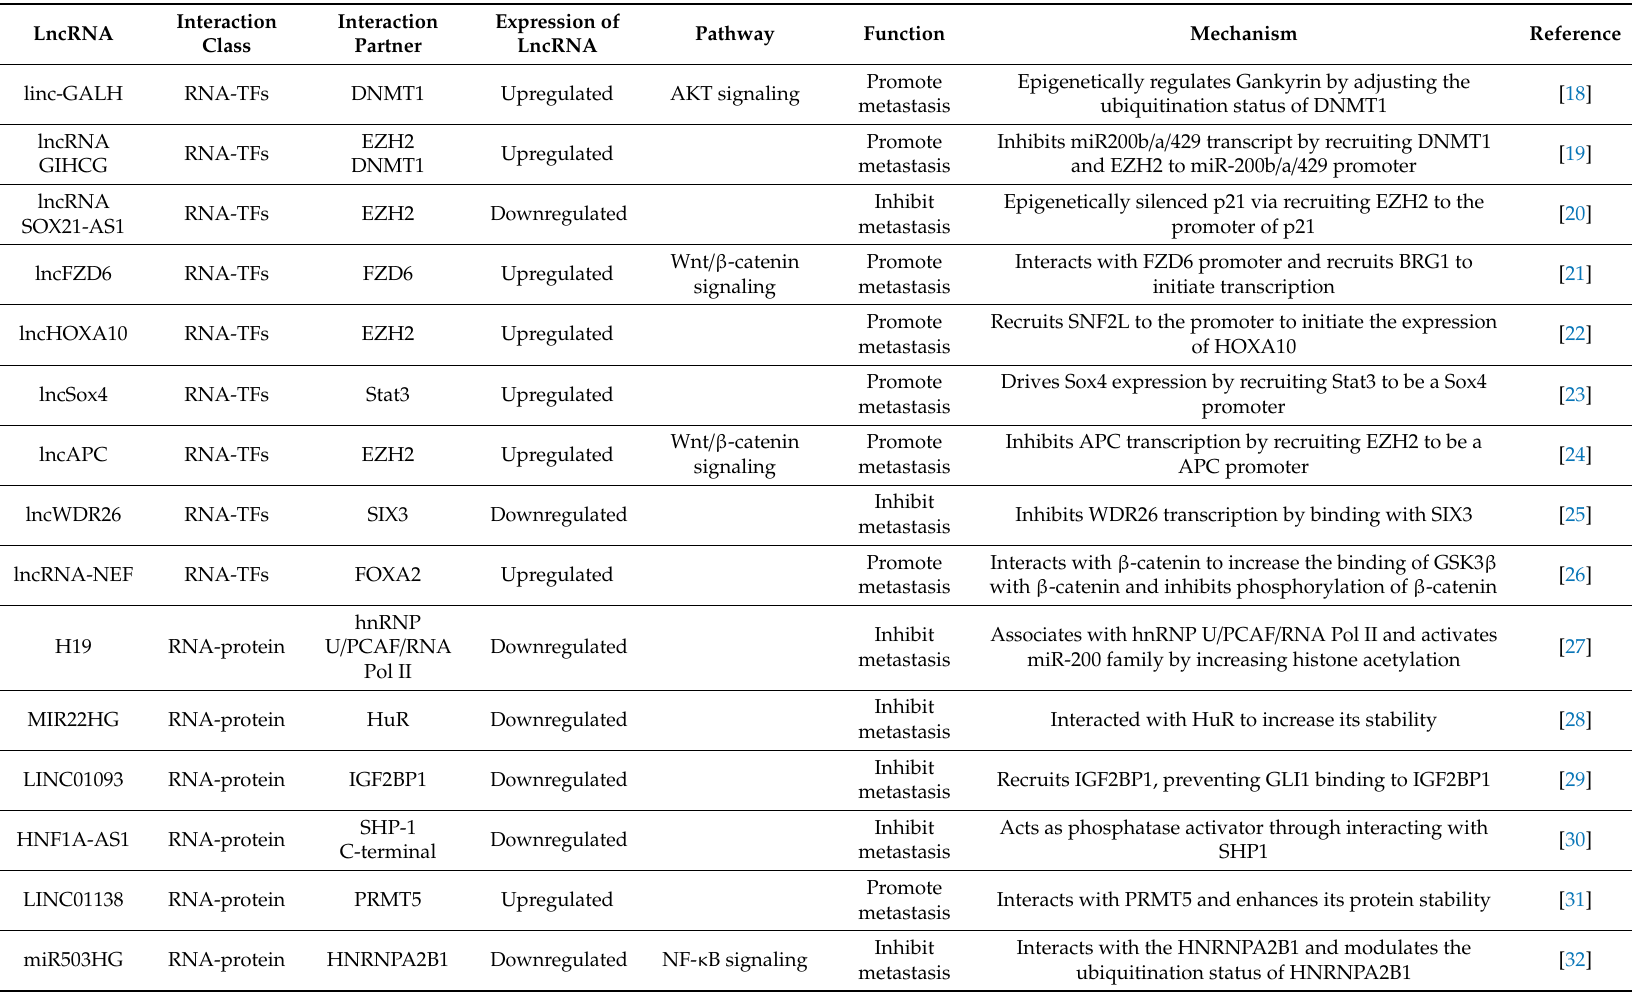
Table 1. Summary of long non-coding RNAs (lncRNAs) involved in the hepatocellular carcinoma (HCC) metastasis at di ff erent molecular